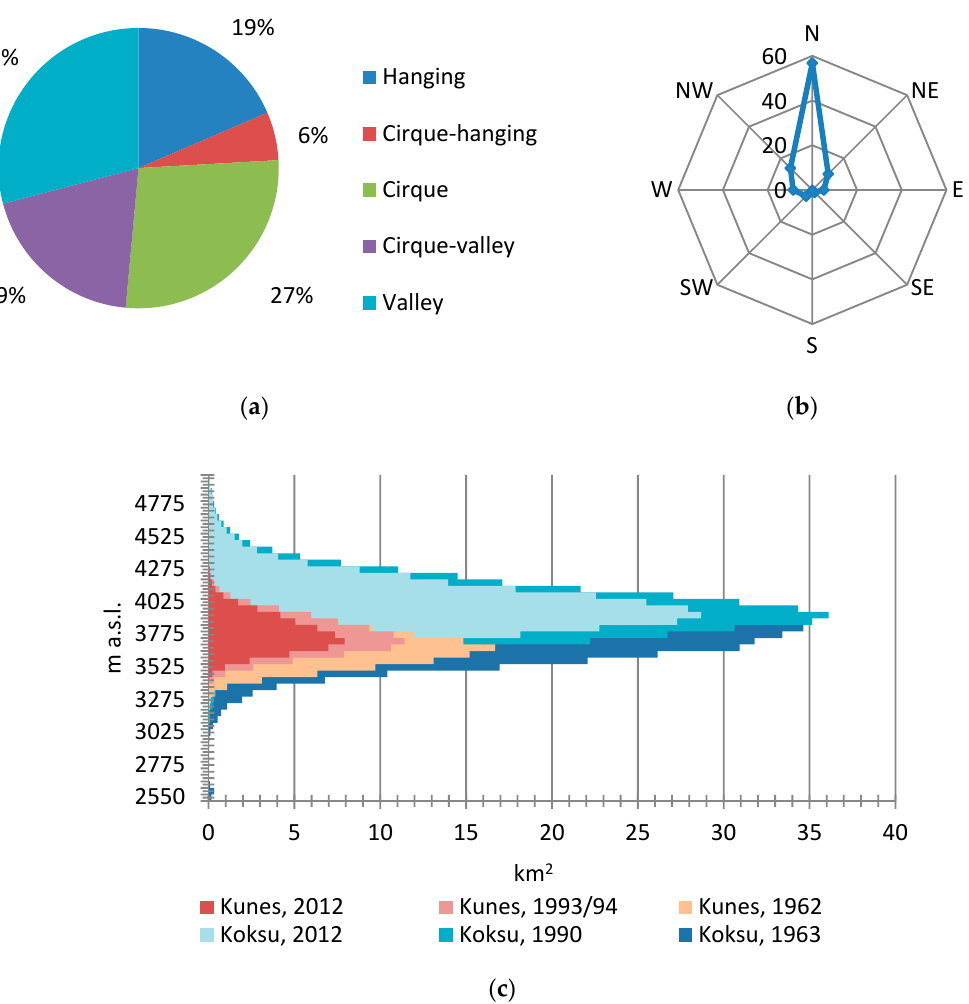
Figure 4. Distribution of glacier area by type ( a ), aspect ( b ) in 2010s, and elevation in 1960s, 1990s, and 2010s ( c ).